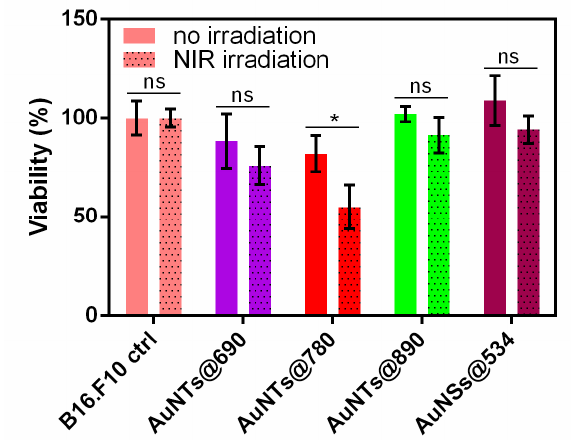
Figure 8. Cell viability of B16.F10 cells treated with different AuNPs before and after NIR irradiation. Two-way ANOVA analysis with Bonferroni posttest (ns, not significant, p > 0.05; * p < 0.05).